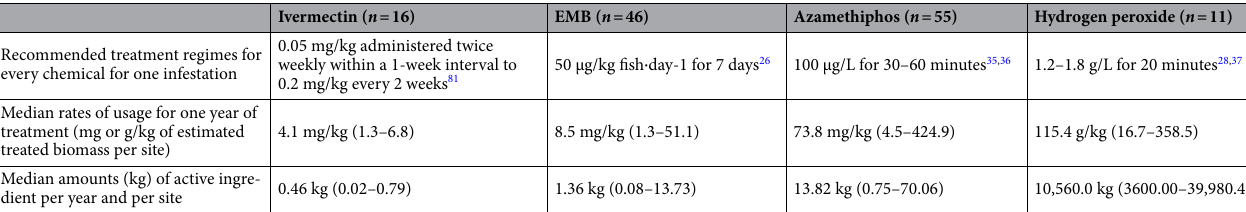
Table 3. Median usage of individual chemicals i.e. active ingredients per site (medians and min–max between brackets) from 2016 to 2019 expressed as total amounts and per fish weight (kg). The number n between brackets indicate the number of total treatments per year per site.